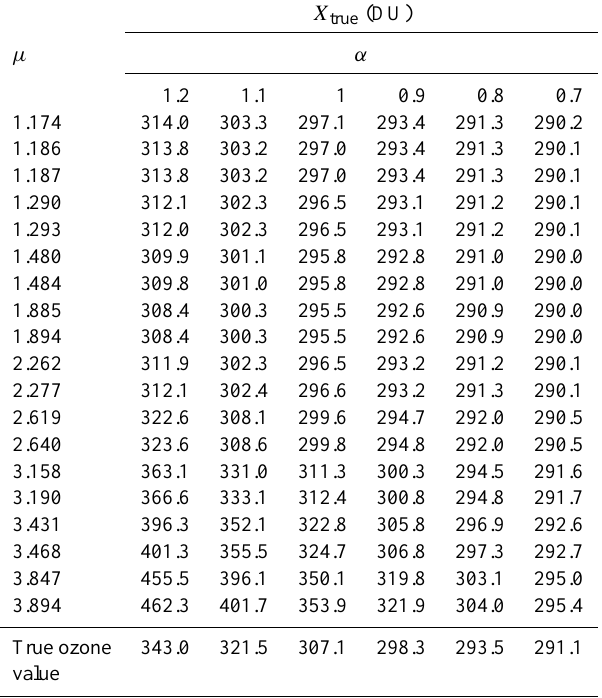
Table 3. X true values for the case of 5 September 2012 for R 0 = 10 − 3 . 8 and all α values ( µ 1 = 1 . 0 and µ 2 = 2 . 5).